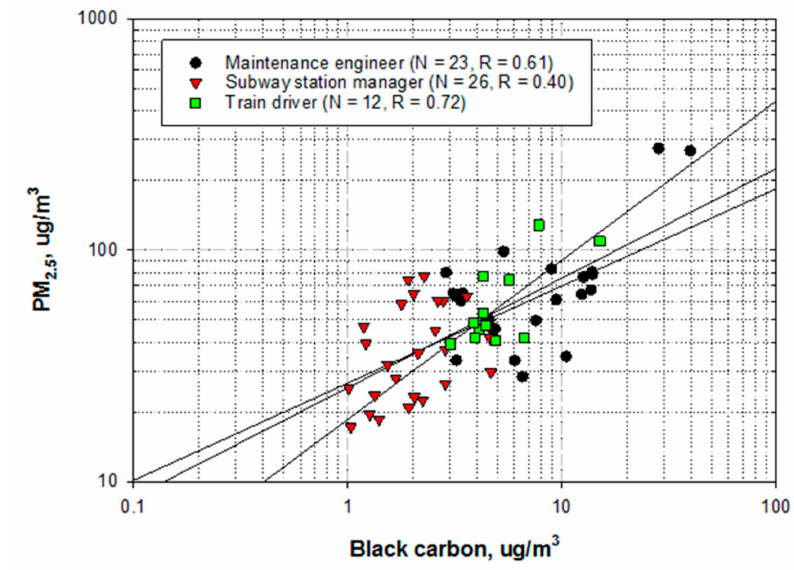
Figure 2. Correlation between the mass concentrations of PM 2.5 and black carbon (BC) by